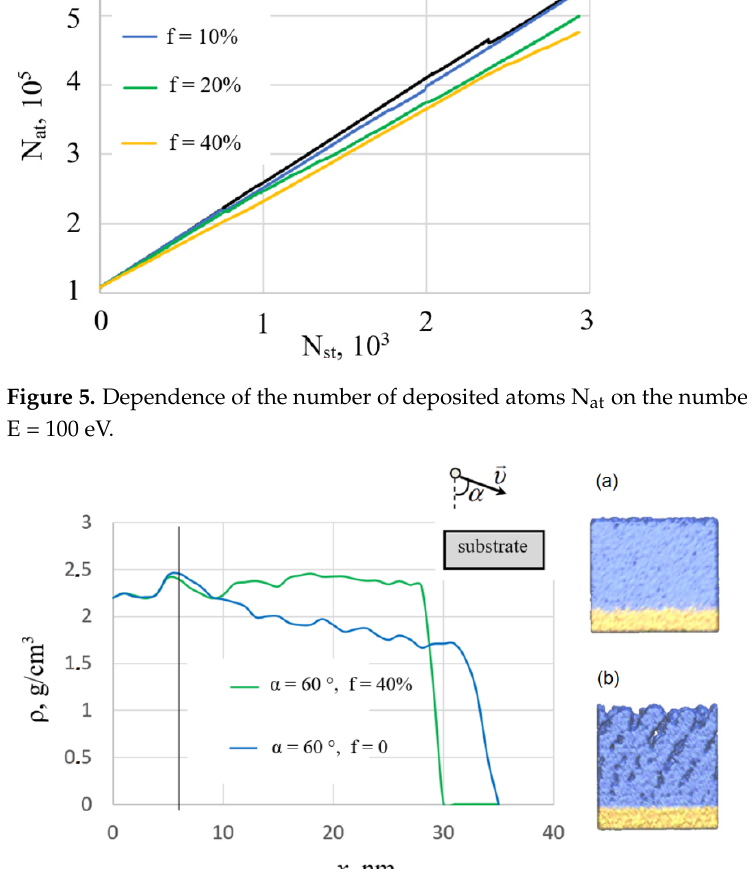
Figure 6. Density profiles of the IAD film deposited with ion assistance at α = 60°, f = 40%, and E = 100 eV (green line), and of the film obtained by the high-energy deposition at an angle α = 60° without ion assistance (blue line).